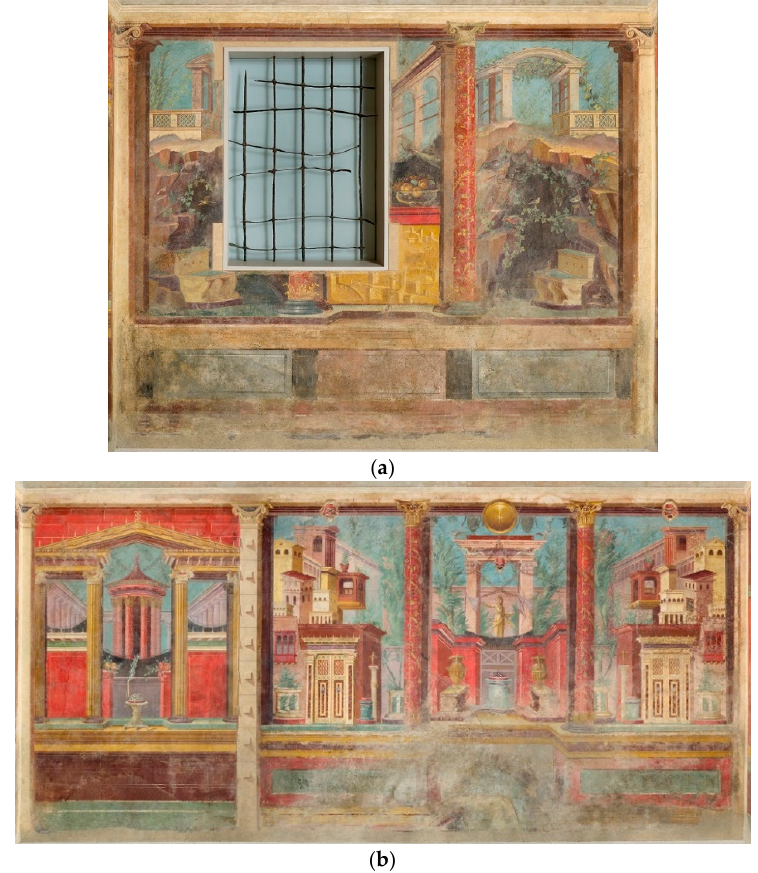
Figure 6. Northern ( a ) and Eastern ( b ) wall of Cubiculum M from the Villa of Boscoreale, second style, New York, Metropolitan Museum, Rogers Fund, 03.14.13d and 03.14.13.c–b; © Public domain dedication (CC0 1.0) (photographs provided by the Metropolitan Museum of Art).